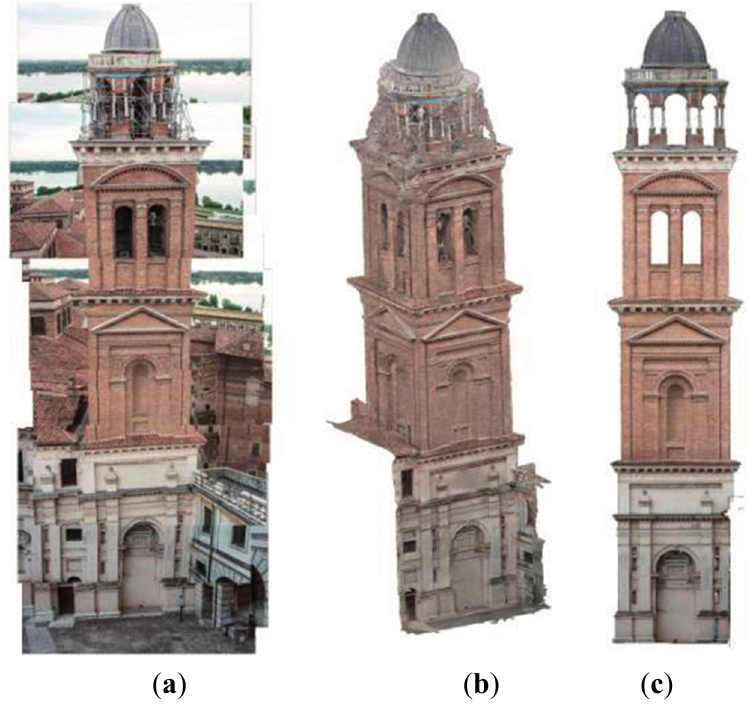
Figure 8. ( a ) example of vertical strip acquisition; ( b ) image-based model; ( c ) front